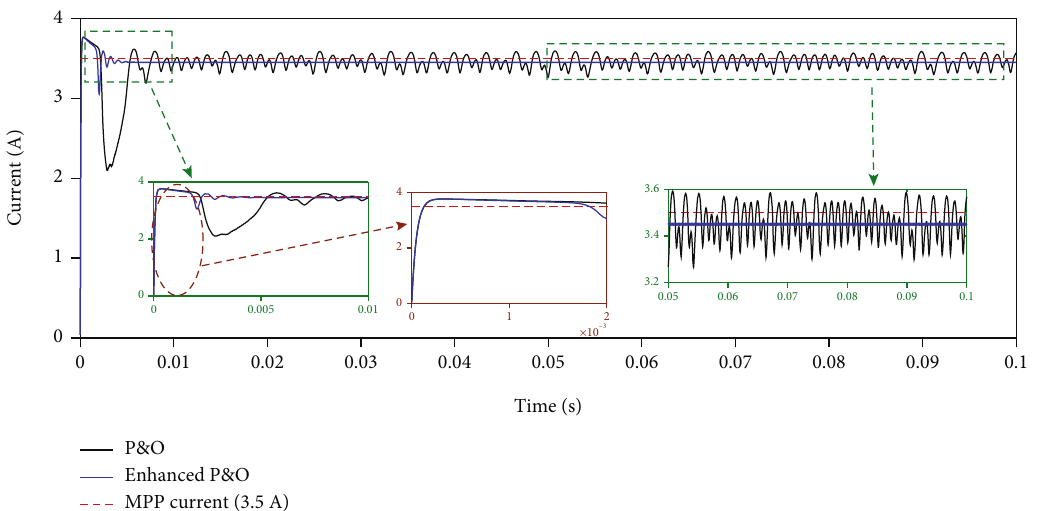
Figure 13: Tracking of MPP current with P&O and enhanced P&O MPPT method under Test